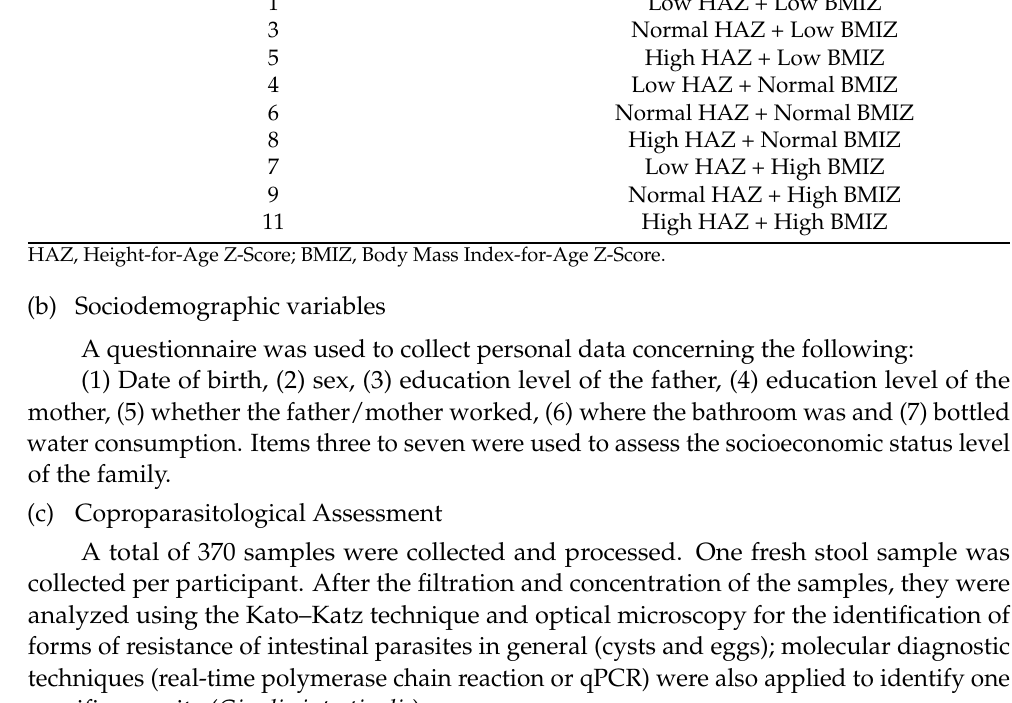
Figure 2. Nutrimetry (taken and translated from Selem-Solis et al. (2017). The different combinations of HAZ and BMIZ result in nine categories, nutricodes, which are assigned nine-digit codes, 1, 3, 4, 5, 6, 7, 8, 9 and 11 (Table 1); these are responsible for representing the different diagnoses of the nutritional status [33]. Table 1. Nutricodes and their interpretations. Nutricodes